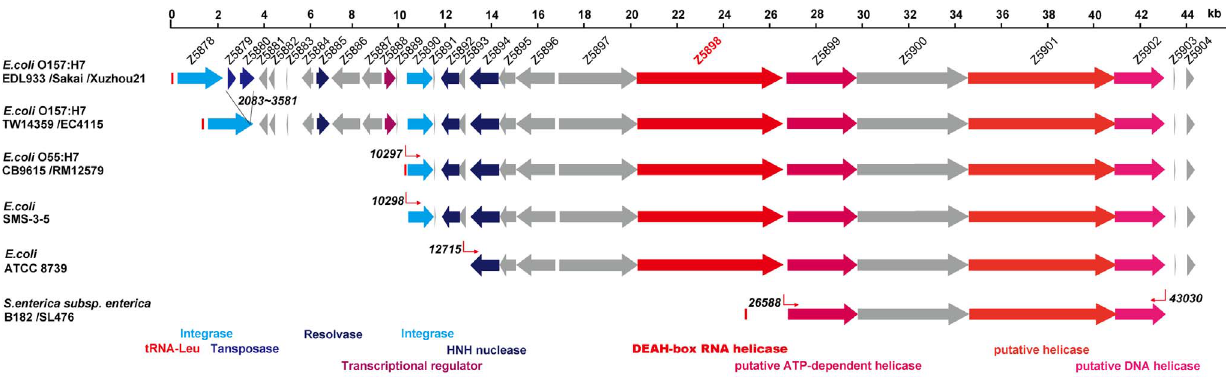
Figure 1. Architecture of OI-172 (MAO island) in E.coli O157:H7 and its homologs in other strains. The DNA sequence of the MAO island of E. coli O157:H7 strain EDL933 was used to search for homologous genes in the GenBank by BLASTn. The scale bar and the locus_tags as annotated in the EDL933 genome are indicated at the top row. Genes of unknown function are shown in grey. Other genes are coloured as shown at the bottom of the figure with putative functions in coloured text. The same color code was used if the genes have the same or similar function. The Genbank accession numbers of the complete genomes used are BA000007 (Sakai), CP001925 (Xuzhou21), CP001368 (TW14359), CP001164 (EC4115), CP001846 (CB9615), CP003109 (RM12579), CP000970 (SMS-3-5), CP000946 (ATCC 8739), CP003416 (B182) and CP001120 (SL476).